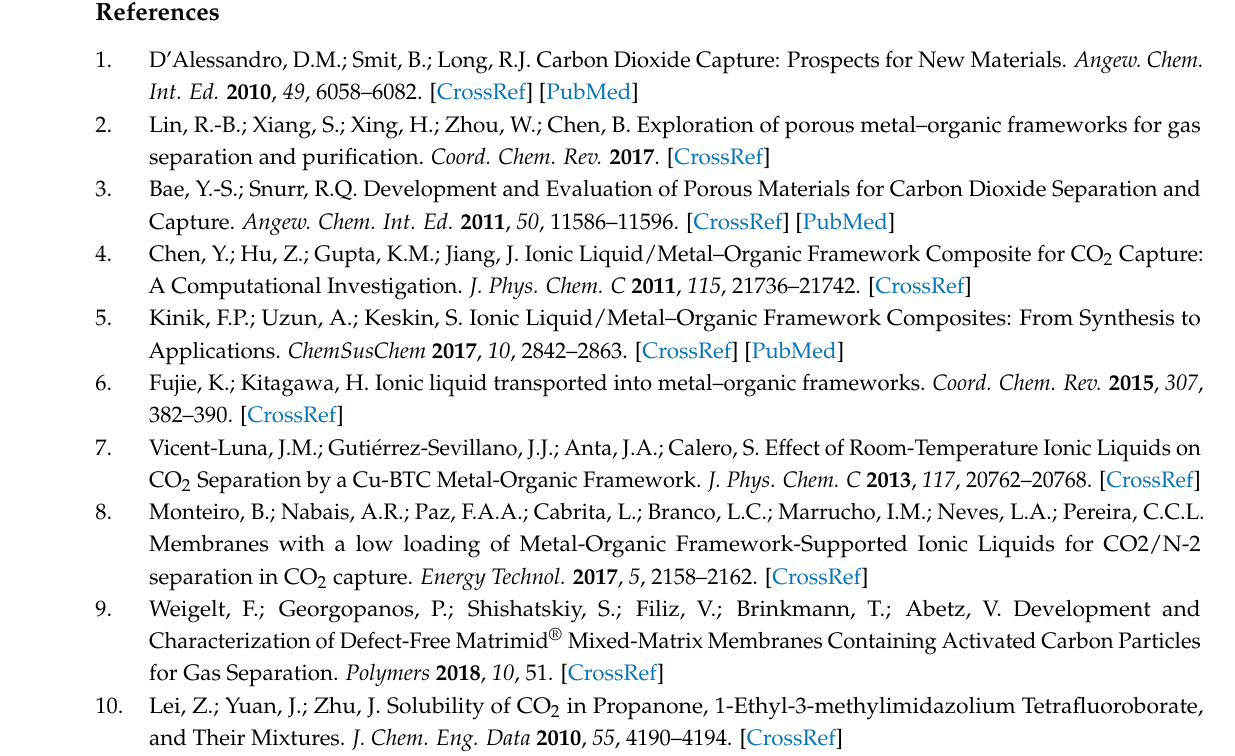
Figure S1: FT-IR spectra of the Cu-BTC precursor (blue line) and the composite [EMIM][BF 4 ]@Cu-BTC (red line) collected in the 400–4000 cm − 1 range. Figure S2: Thermogravimetric analysis of [EMIM][BF 4 ] (green line), Cu-BTC (blue line) and [EMIM][BF 4 ]@Cu-BTC (red line) in the range 20–600 ◦ C. Figure S3: Powder XRD pattern for the precursor Cu-BTC (blue line) and the [EMIM][BF 4 ]@Cu-BTC composite (red line). Figure S4: SEM images of the [EMIM][BF 4 ]@Cu-BTC